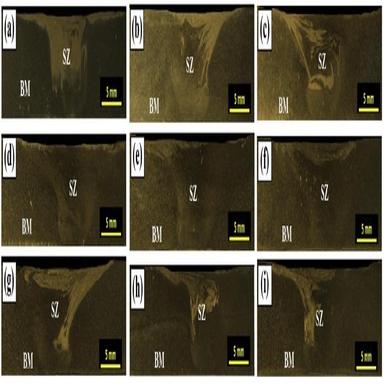
Stereographic macro-images showing the cross-sectional material flow profiles. Single AA6061-TiB2 composites with different ratios of TiB2 particles as; (a) 10 wt%, (b), 20 wt%, and (c) 30 wt%. Single AA6061-Graphene nanocomposites with different ratios of graphene platelets as; (d) 0.5 wt%, (e), 1 wt%, and (f) 2 wt%. Hybrid AA6061-Graphene-TiB2 nanocomposites with different ratios of graphene and TiB2 particles as; (g) 0.5 wt%-20 wt%, (h), 1 wt%-20 wt%, and (i) 2 wt%-20 wt %.